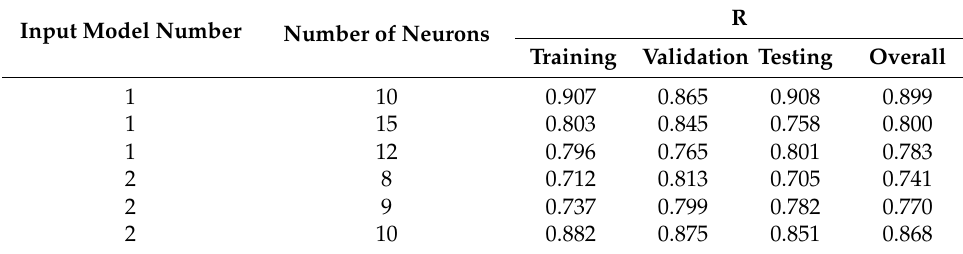
Table 5. Correlation coefficient (R) of artificial neural network (ANN) network structure